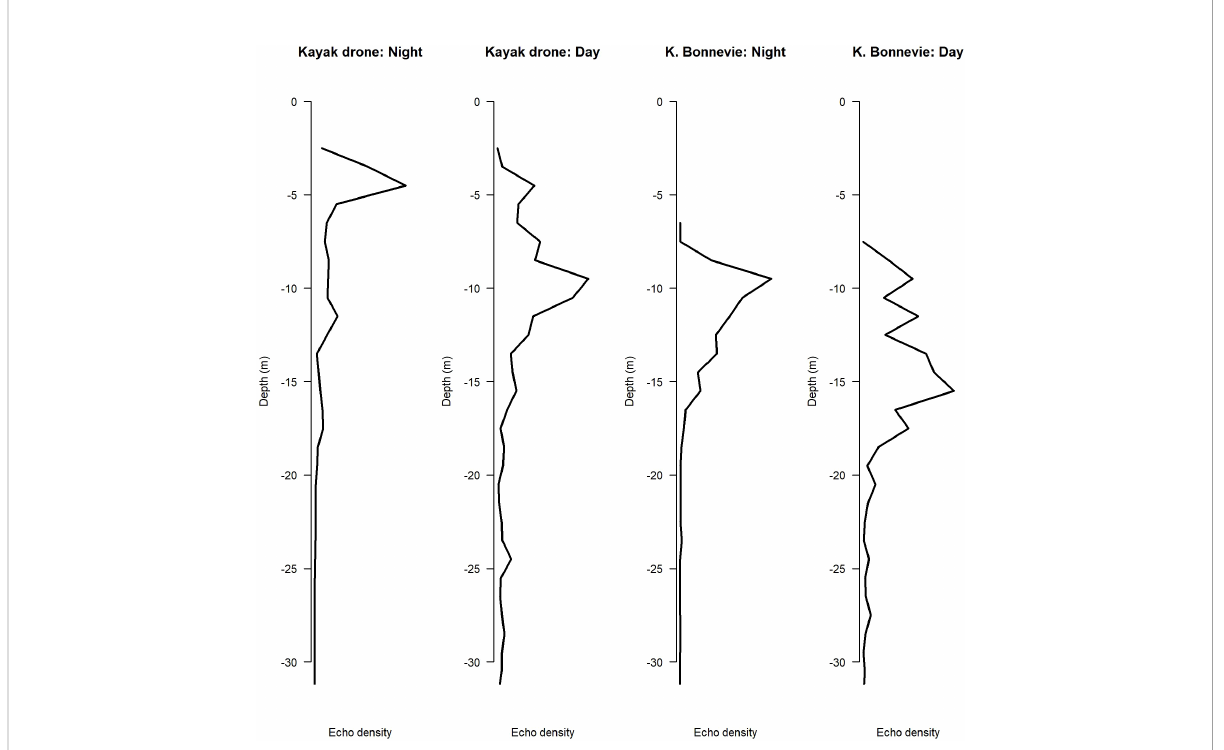
FIGURE 6 The echo density of sprat by depth, measured from the Kayak Drone and the research vessel Kristine Bonnevie (Årdalsfjorden, Norway, August